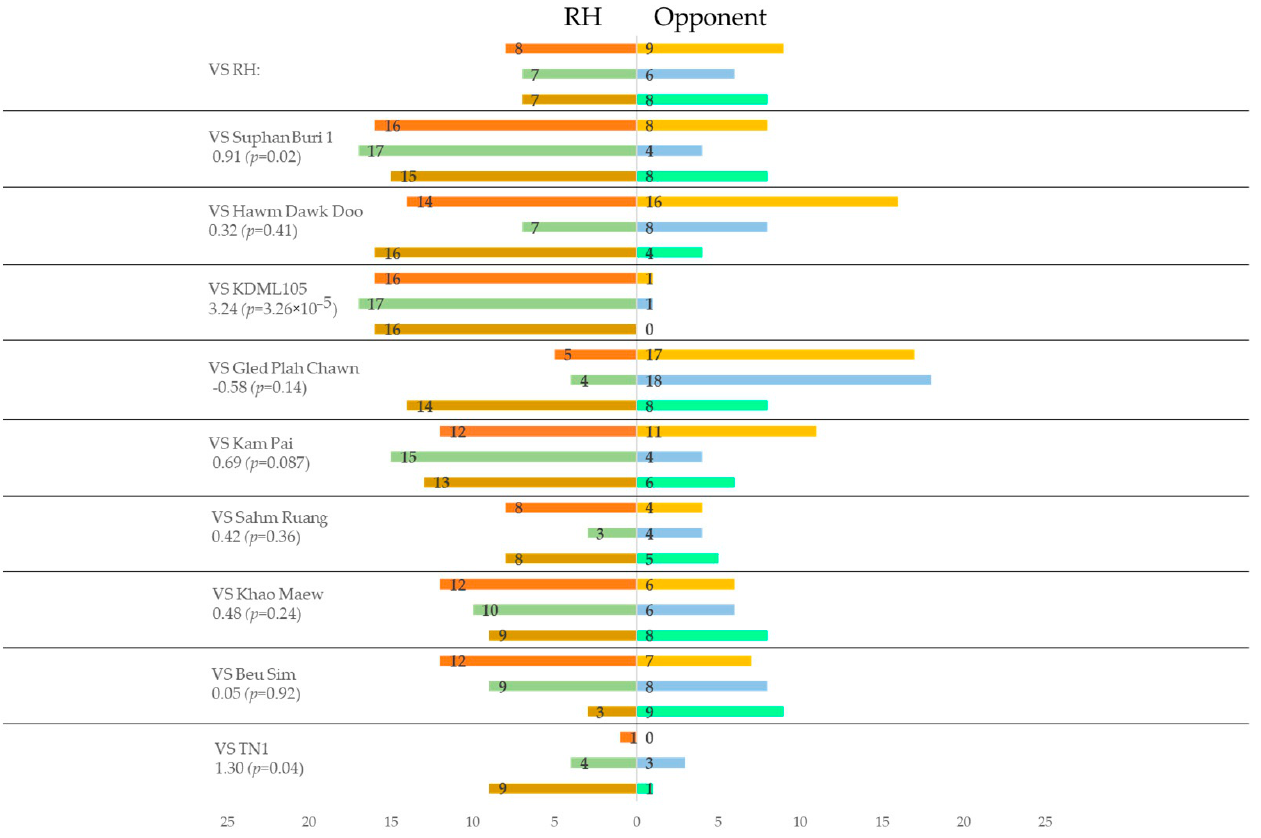
Figure 2. Relative olfactory preferences of BPH for volatiles from rice plants of RH variety to the others determined by two − choice tests using potted plants without BPH infestation.